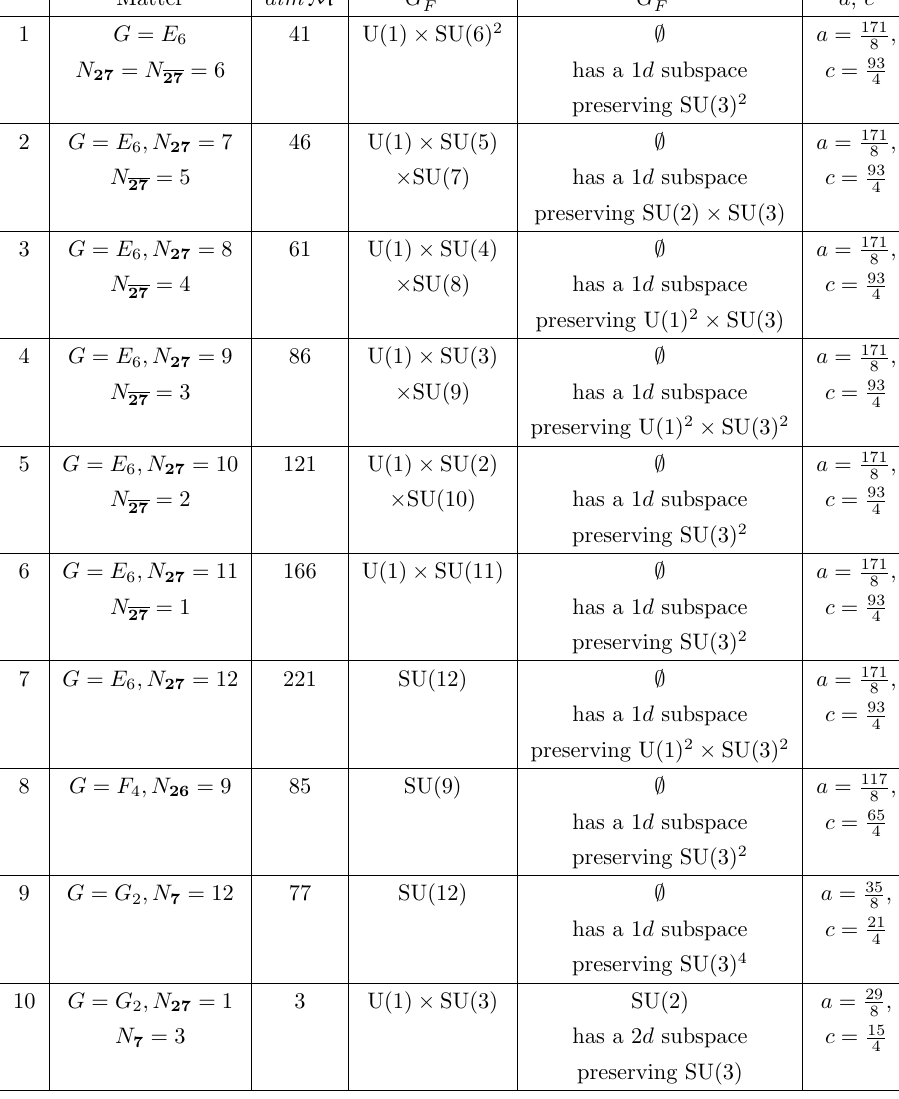
Table 24 . Cases involving an exceptional gauge